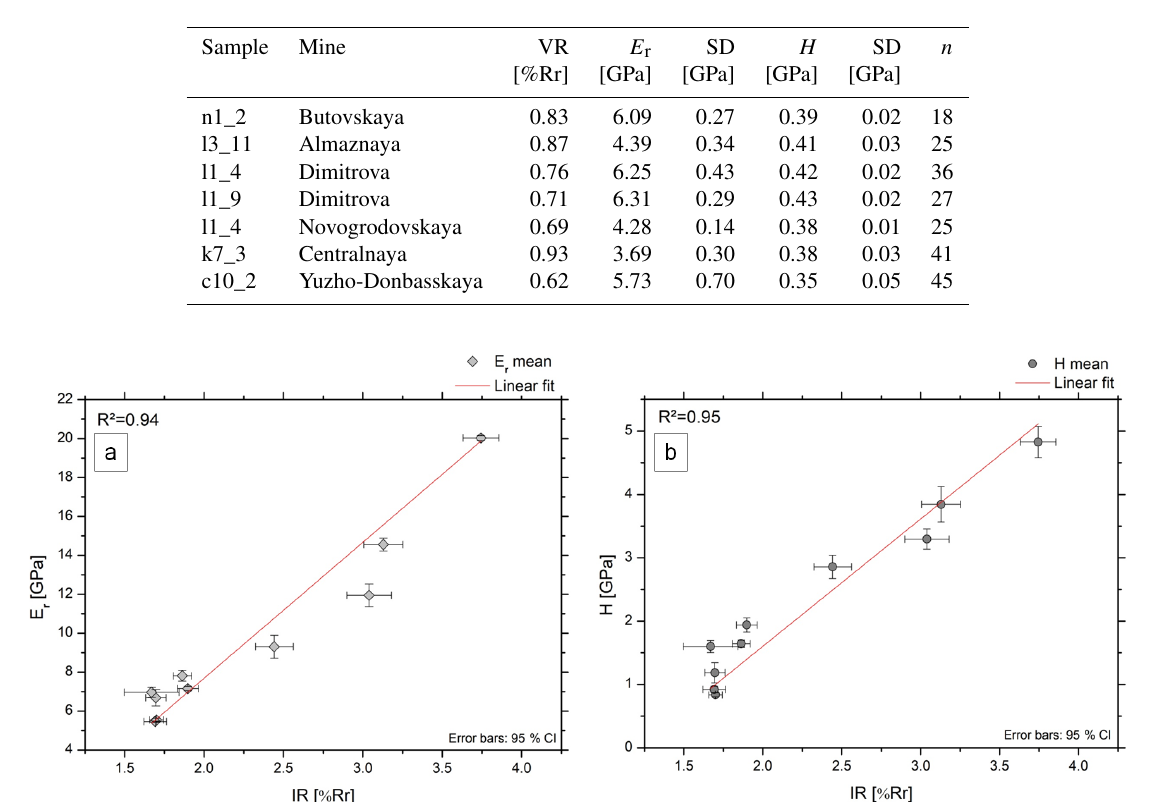
Table 4. H and E r averages obtained from sporinites, including standard deviations (SD) calculated from the respective number of measure- ments ( n ).